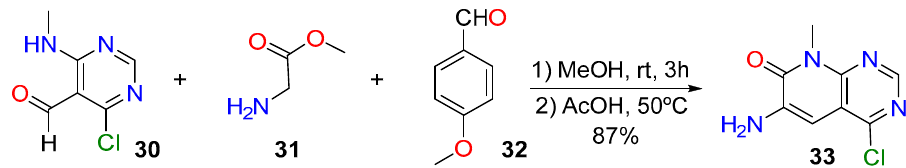
Figure 14. Synthesis of the 4-chloro substituted pyrido[2,3- d ]pyrimidin-7(8 H )-one ( 33 ) from the chloro substituted pyrimidine aldehyde ( 30 ).